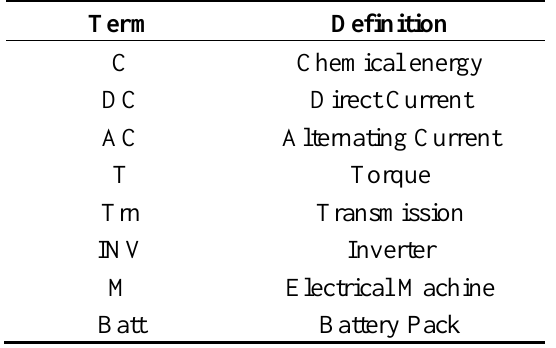
Table 3. Abbreviations used for diagrams.